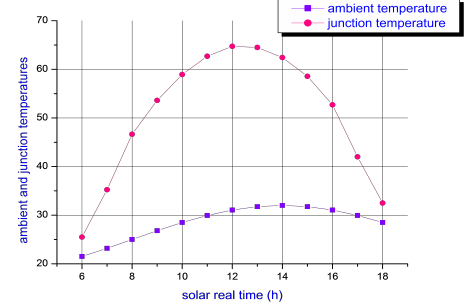
Fig. 6: Temporal evolution of ambient and junction temperatures for n = 228 with a pure sky.